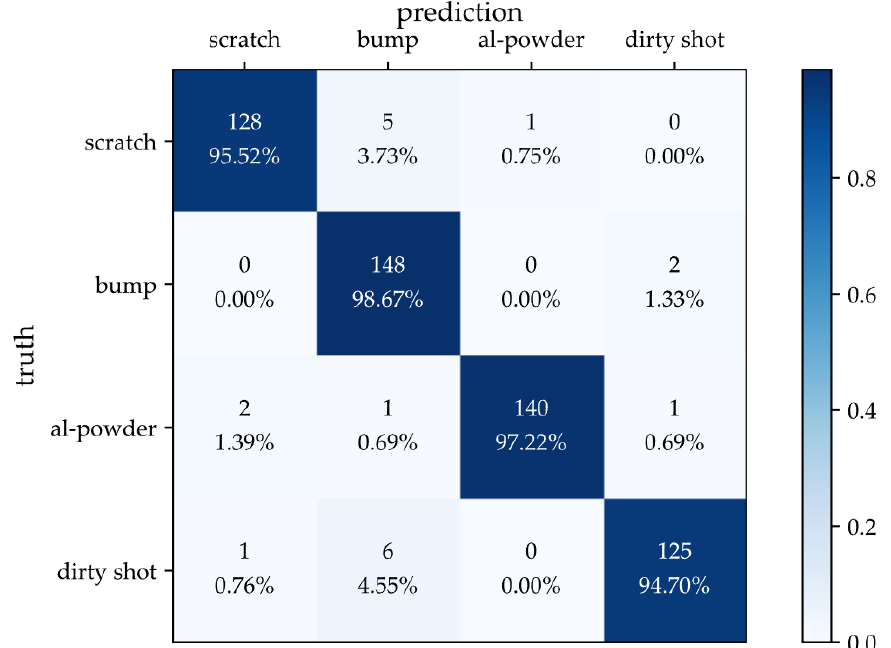
Figure 12. Normalized confusion matrix of deep residual network incorporating deformable convolution.